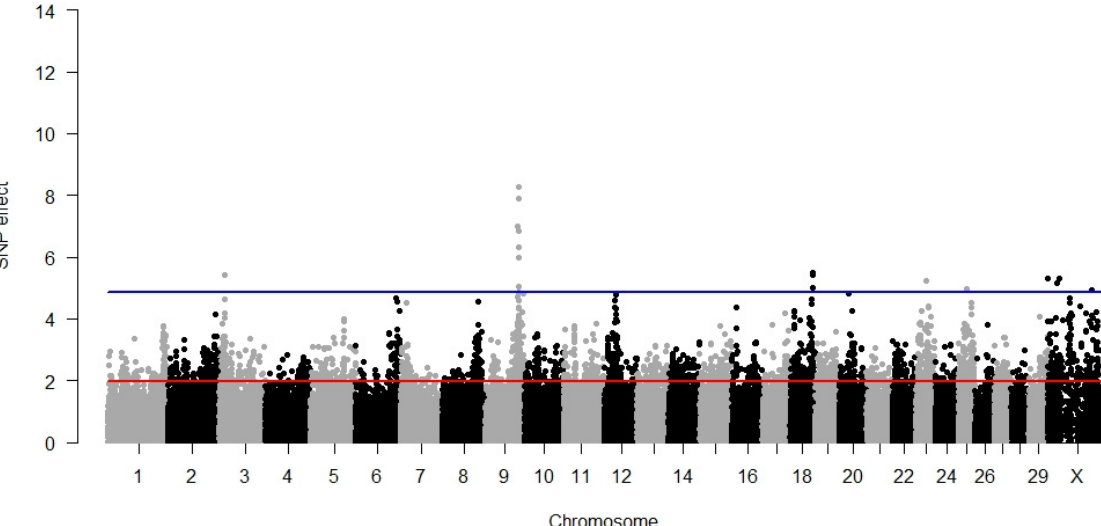
Figure 3. GWAS results for direct stillbirth. The red line (1.96) represents a nominal and the blue line (4.88) a Bonferroni-corrected critical value corresponding with a 5% significance level.